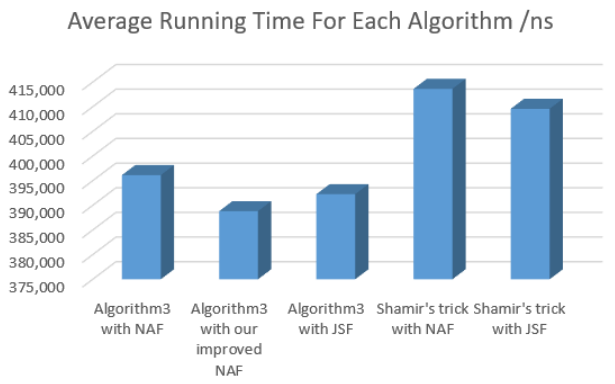
Figure 5. Average running time for each algorithm.